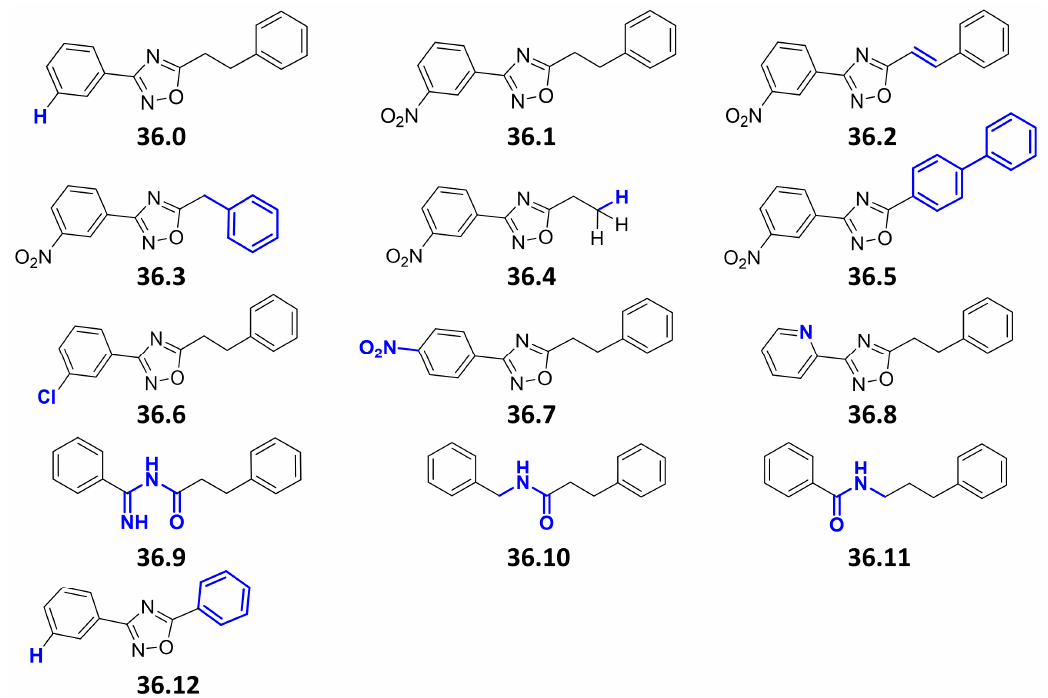
Figure 1. Chemical structures of compound 36 derivatives . Chemical variations between the original hit compound 36.1 and its newly synthesized derivatives are highlighted in blue. The compounds 36.0; 36.1; 36.2; 36.3; 36.4; 36.5; 36.6; 36.7; 36.8; 36.9 showed a MIC 50 > 40 μ M when tested against Mtb H37Rv or M. marinum M USA . No toxicity to THP-1 cells was observed at concentrations up to 40 μ M . Compounds 36.10, 36.11, and 36.12 were not tested.